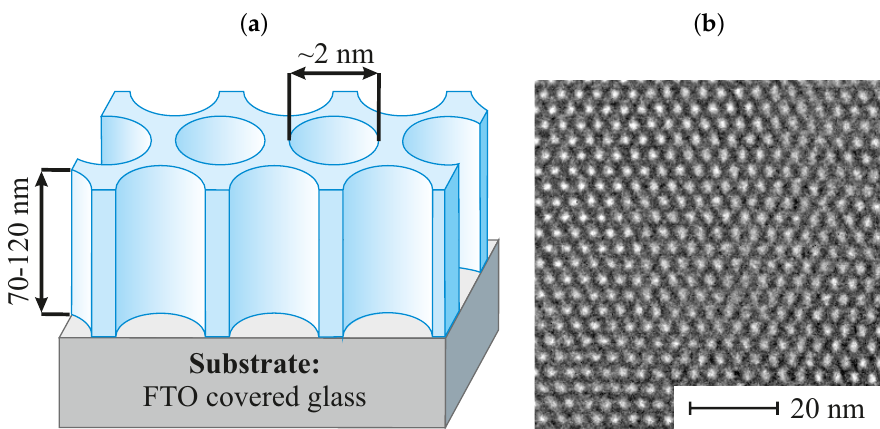
Figure 1. The structure of a vertically aligned porous silica thin film prepared via electro-assisted self-assembly method (EASA): scheme ( a ) and TEM microphotography ( b